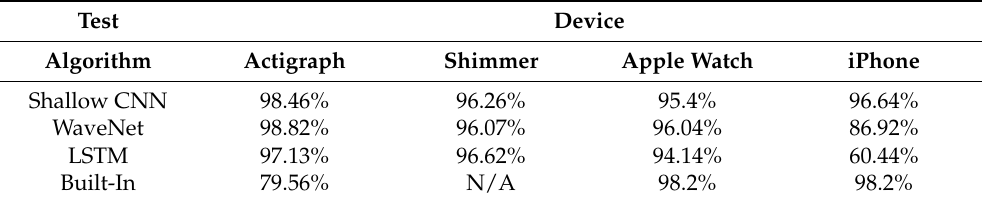
Figure 9. Results of testing the general models on an independent dataset using ENMO. Each dot correspond to one subject (blue dots indicate data in [38]). Table 2. Step count accuracy of testing general models on independent dataset using